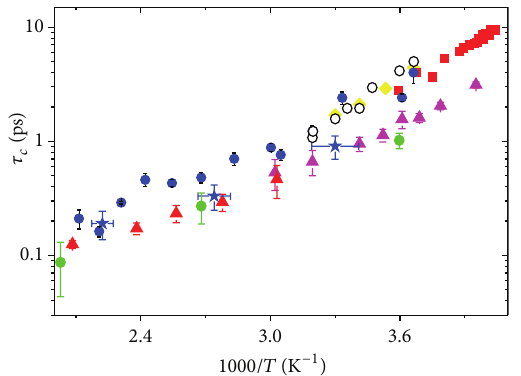
Figure 15: The Arrhenius plot of the relaxation time of water as measured by various techniques. (i) Results from the viscoelastic analysis of the IXS line-shape [13] (blue dots) are compared with the relaxation times reported in Figure 12 with the same symbols.